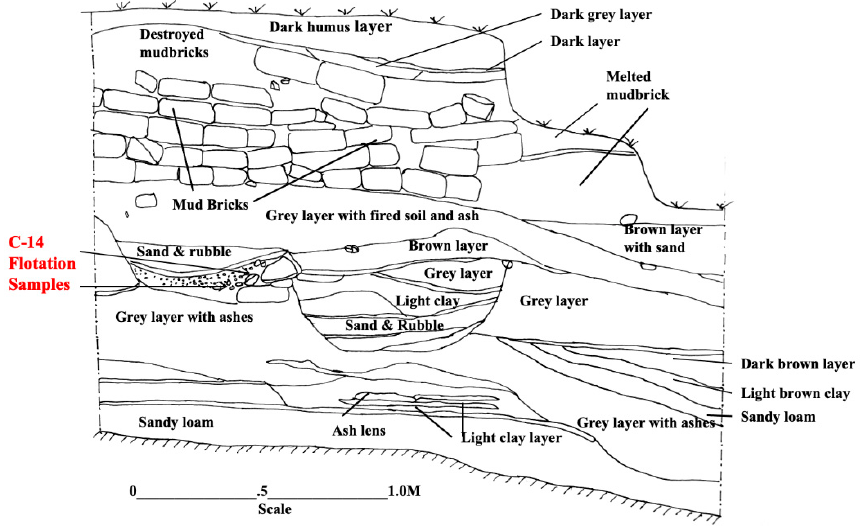
Figure 5. Archaeological Stratigraphy at Settlement 2 (EJS2). A section of a dwelling. West facing profile.